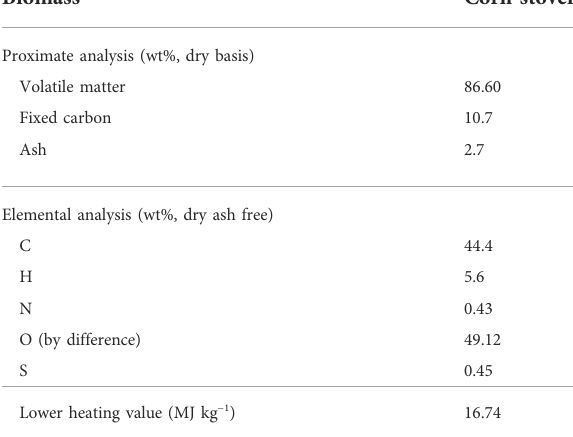
TABLE 3 Proximate and elemental analyses of the biomass used in the simulation (Manyà et al., 2018). Biomass Corn stover Proximate analysis (wt%, dry